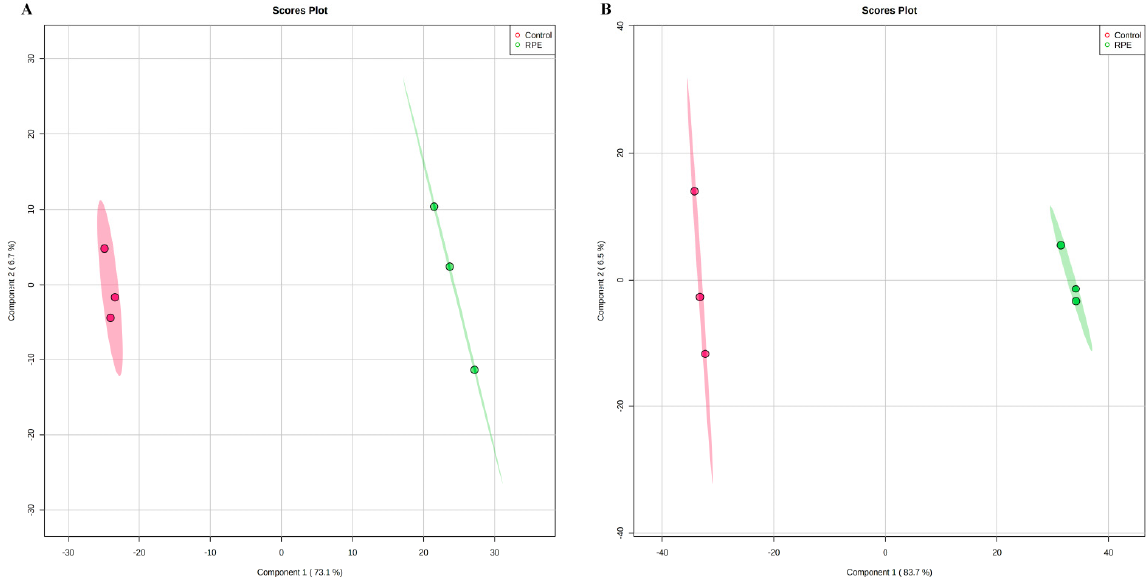
Figure 5. OPLS-DA spot of RPE treated on S. aureus and MRSA compared with untreated respectively. ( A ) OPLS-DA analysis of effects of RPE treatment of S. aureus relative to control. Each point represents a duplicate sample in each group ( n = 3). ( B ) OPLS-D analysis of effects of RPE treatment of MRSA versus control. Each dot in the figure represents a duplicate sample in each group ( n = 3).